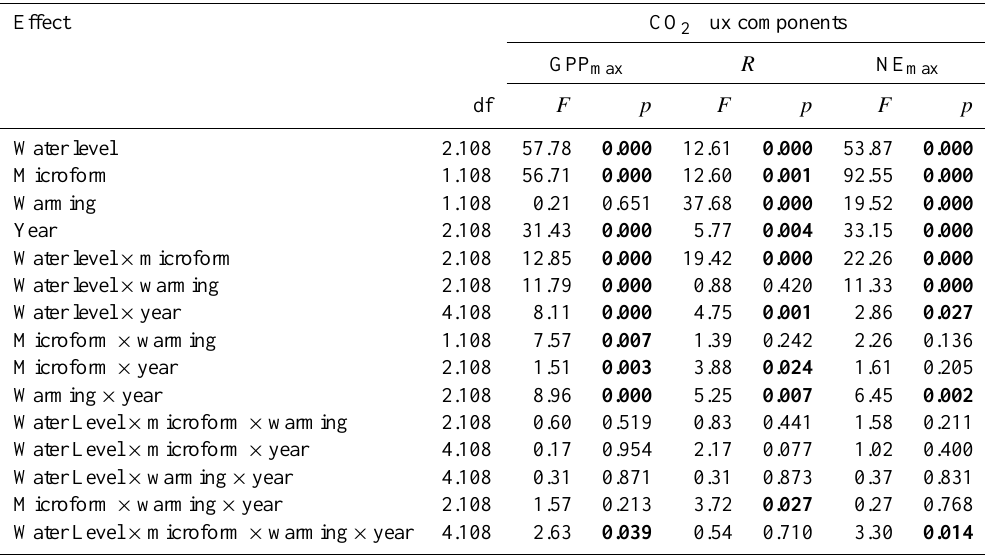
Table 3. Mixed-effects ANOVA F and p values on CO 2 fluxes at the peatland surface for the fixed effects of water level treatments (control, experimental, drained), warming treatments (non-OTC, OTC), microform types (hummock, hollow) and years (2011, 2012, 2013) with repeated measures of year ∗